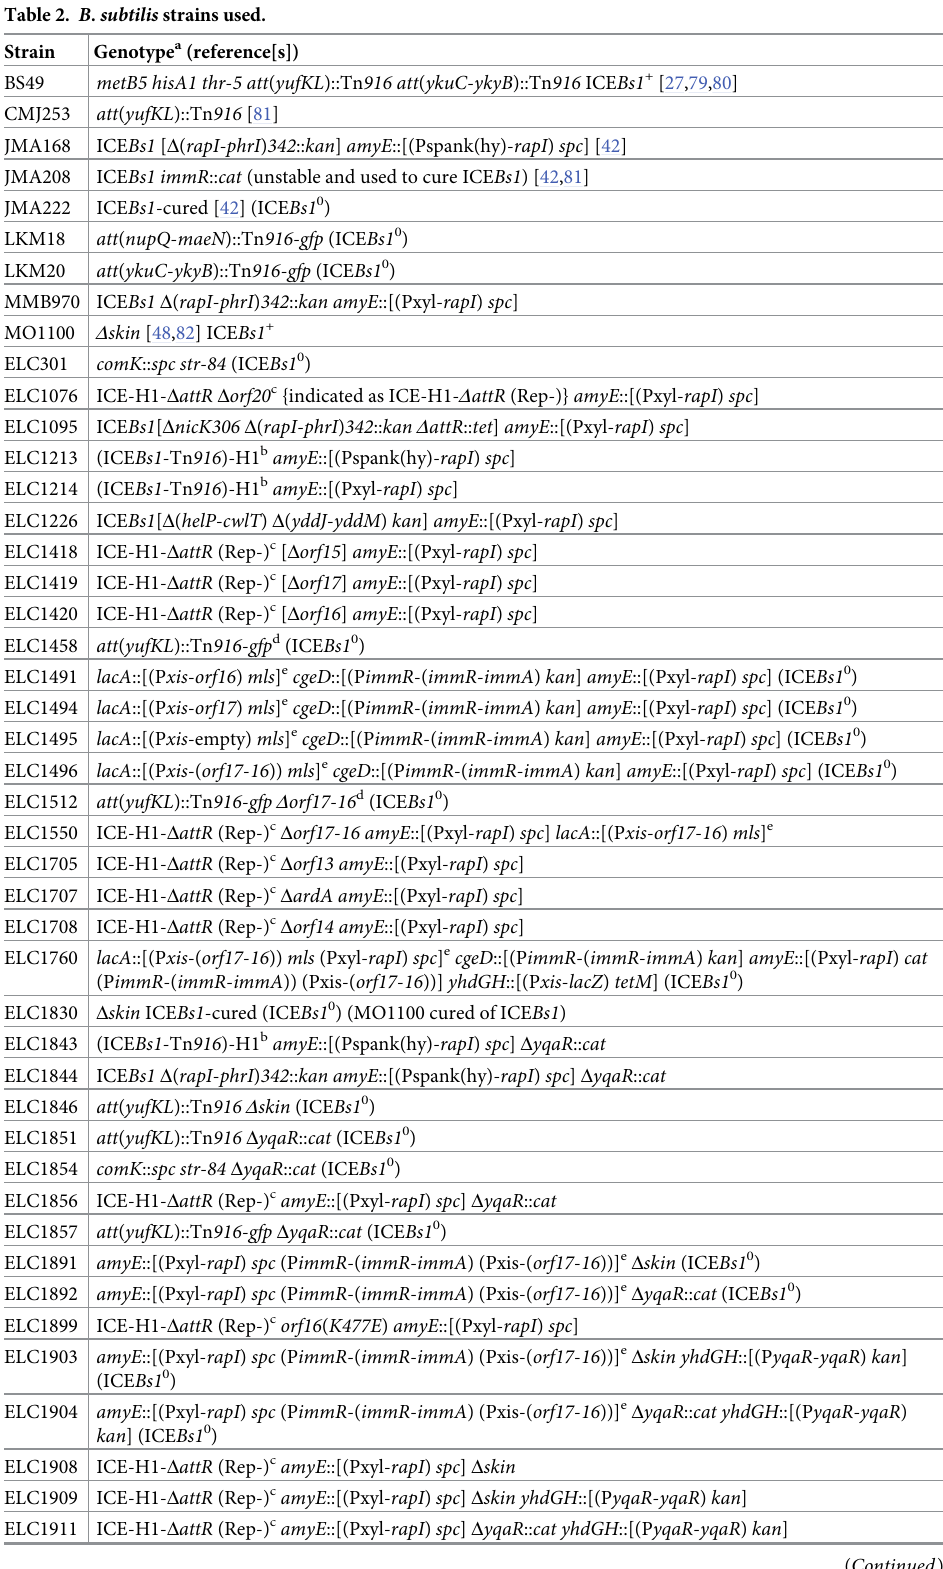
Table 2. B . subtilis strains used.